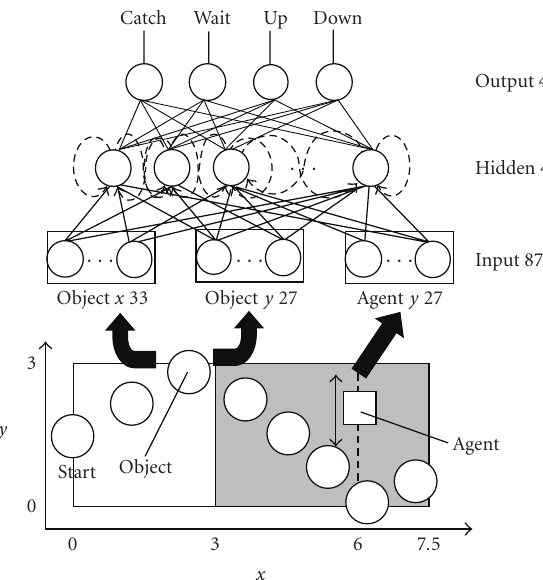
Figure 1: Object catching task and a recurrent neural network. An agent moves up or down and catches a moving object. The initial direction of motion and velocity of the object are chosen randomly for every episode. The invisibility area is also chosen randomly in the range of x > 3 . 0. x , y coordinates of the object and y coordinate of the agent are input to an Elman-type recurrent neural network. Each input signal represents local information, as shown in Figure 2.